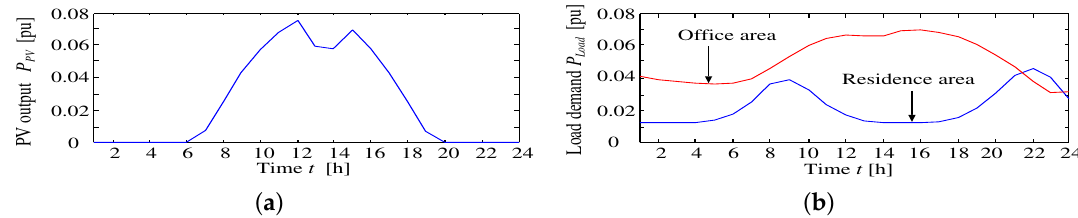
Figure 7. PV output and load demand curve. ( a ) PV output and ( b ) load demand profile for each